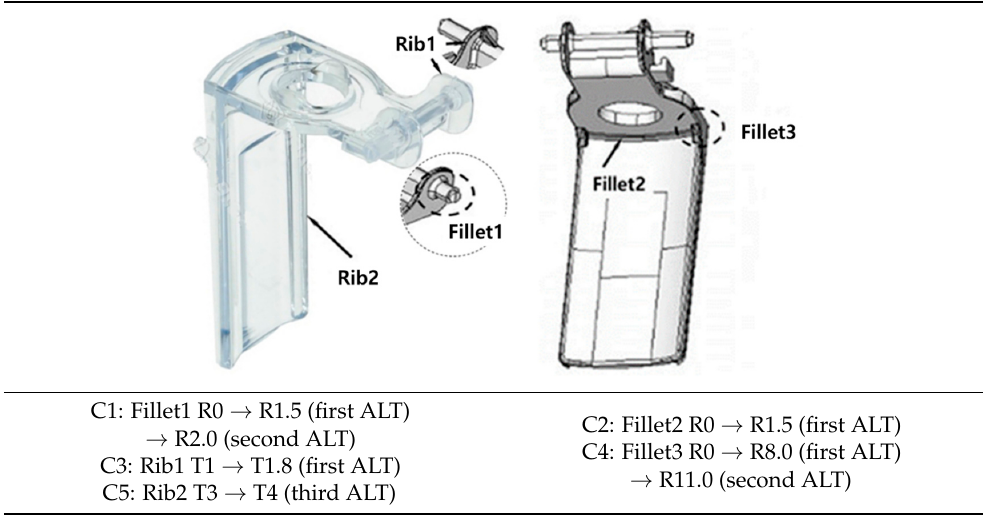
Table 3. Summary for the redesigned dispenser lever.